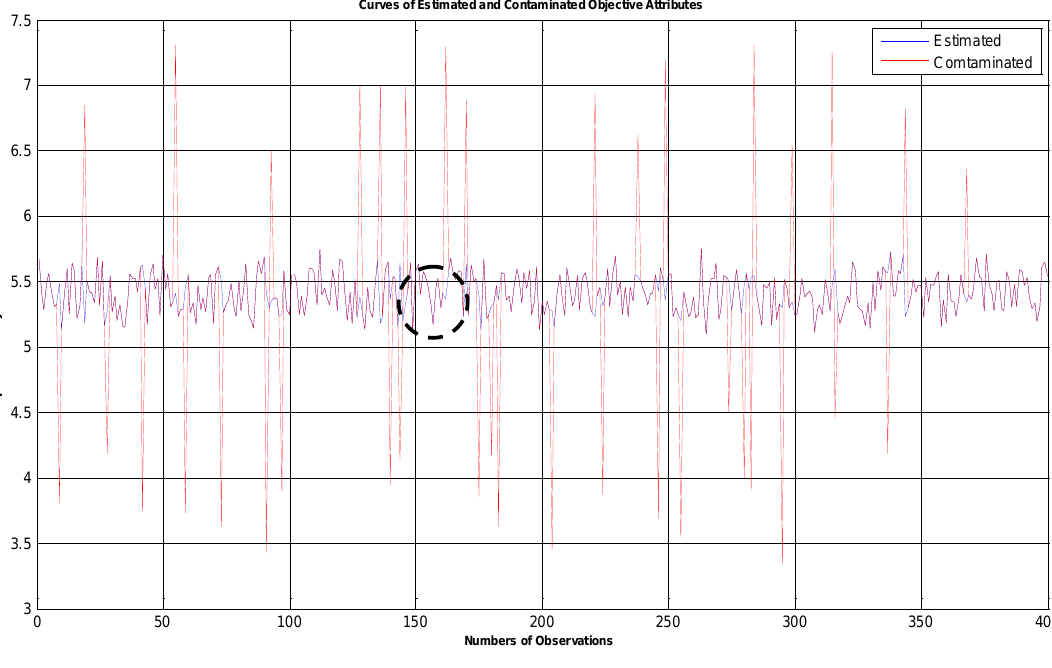
Figure 8. Zoom in the curve marked by a dotted circle in Figure